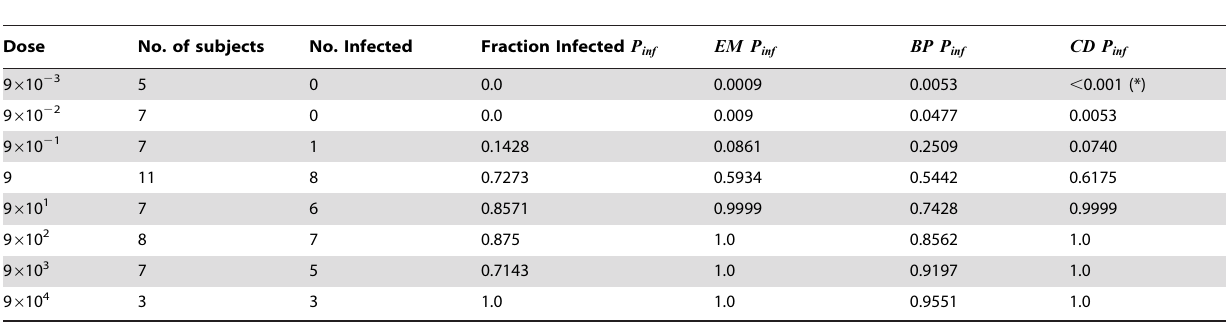
Table 3. Probability of infection from experimental data for Rotavirus ( P inf ) compared to the the Exponential, Beta-Poisson and Cumulative Dose